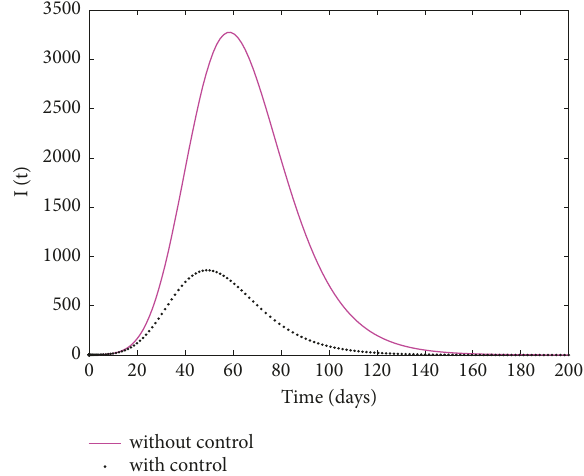
Figure 19: Behaviour of the COVID-19-infected individuals with and without vaccination control.